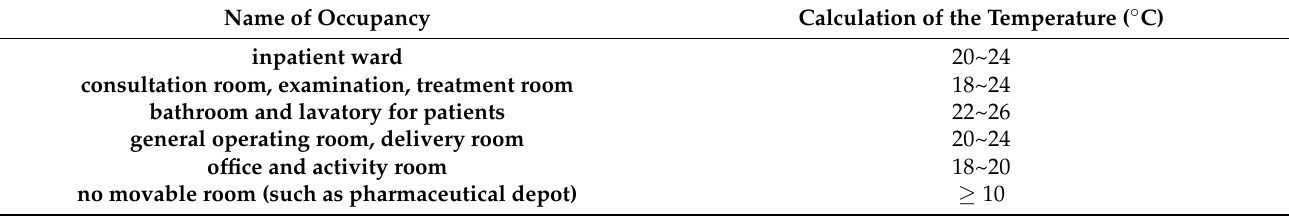
Table 18. Calculate the air conditioner temperature in each area.